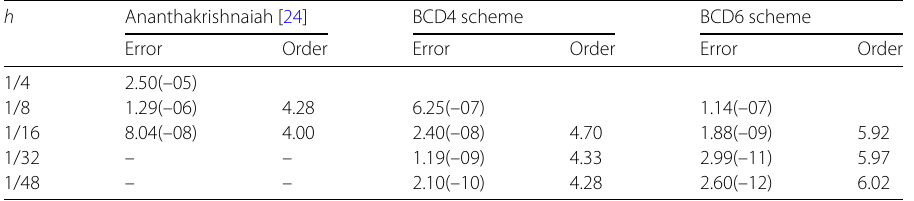
Table 2 The maximum error and convergence order for Problem 2